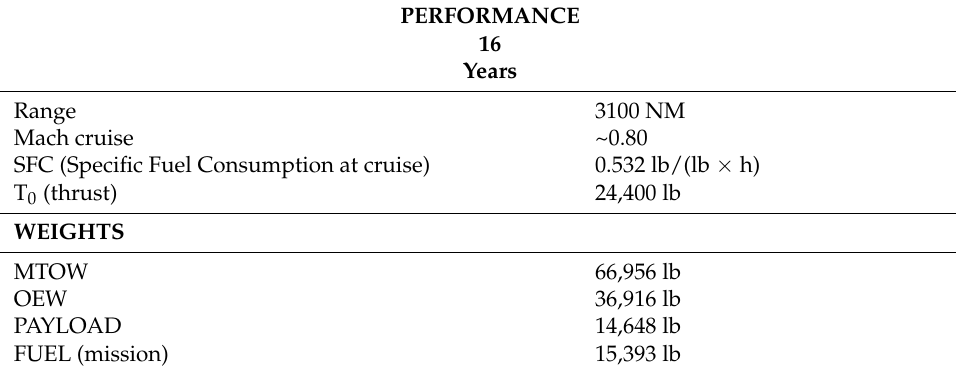
Table 5. Data for DOC estimation: reference mission data and